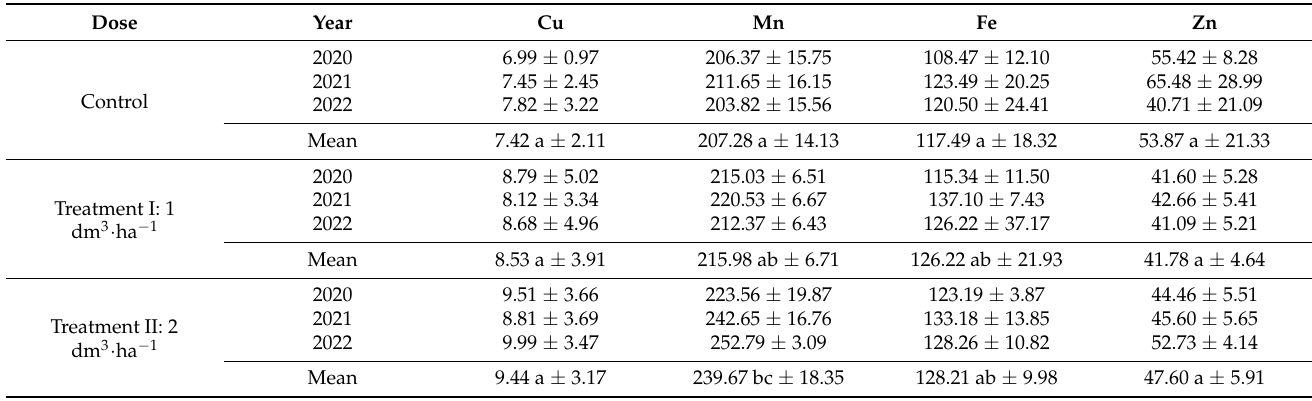
Table 9. Effect of mineral-organic multi-component fertilizer application on the microelement content in plants (mg · kg − 1